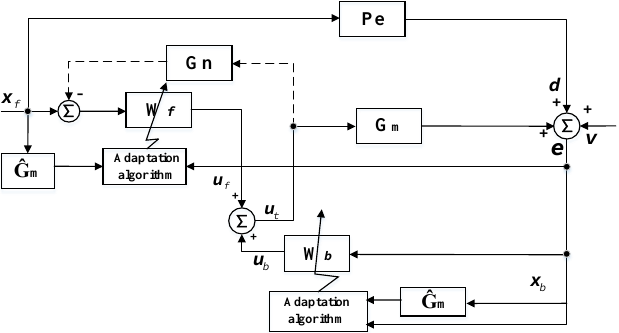
Figure 1. Block diagram of the MIMO simplified hybrid active noise control system, mainly including reference signals vector x f , error signals vector e , two nominal plant responses matrices G m and G n , two control filter matrices W f and W b .